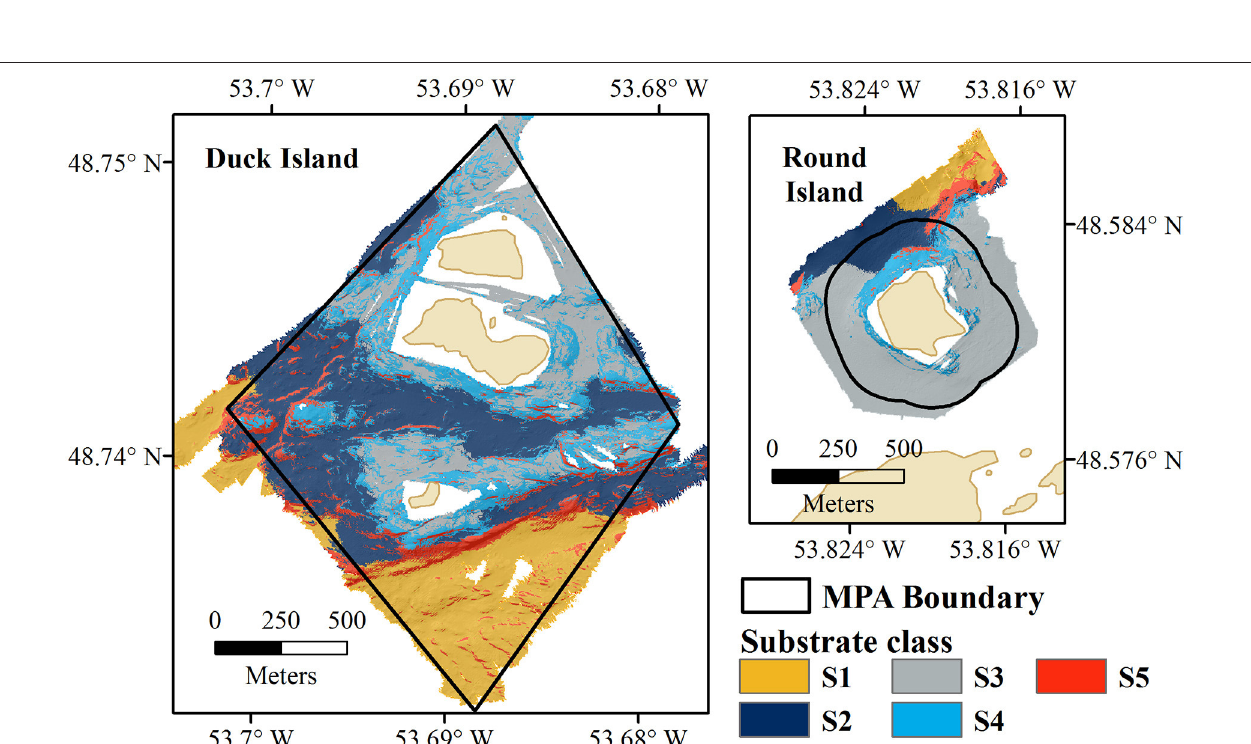
FIGURE 3 | Eastport MPA substrate classification results for Duck Island (Left) and Round Island (Right) .